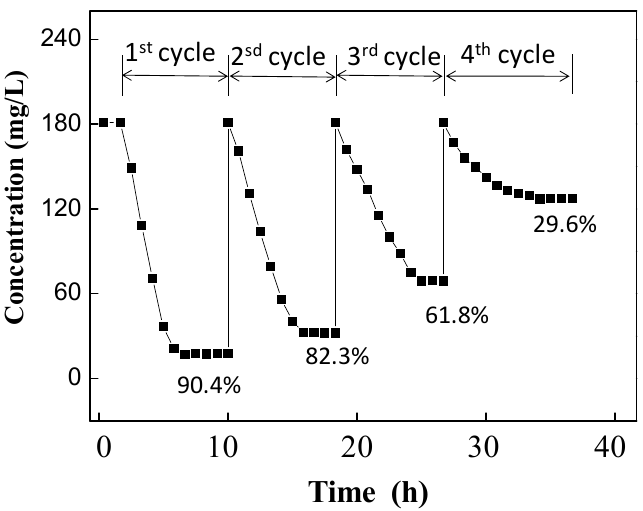
Figure 5. The Bacillus licheniformis FZUL-63 selectively mineralizes and recovers gold from aqua regia-based metal wastewater through four cycles.